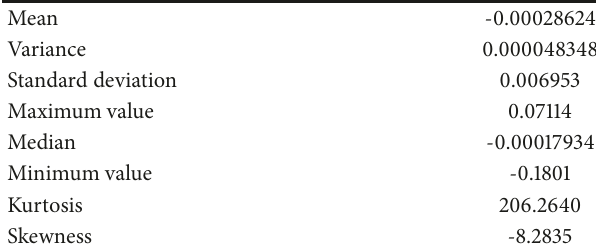
Table 6: Descriptive statistical analysis for the mid-price return